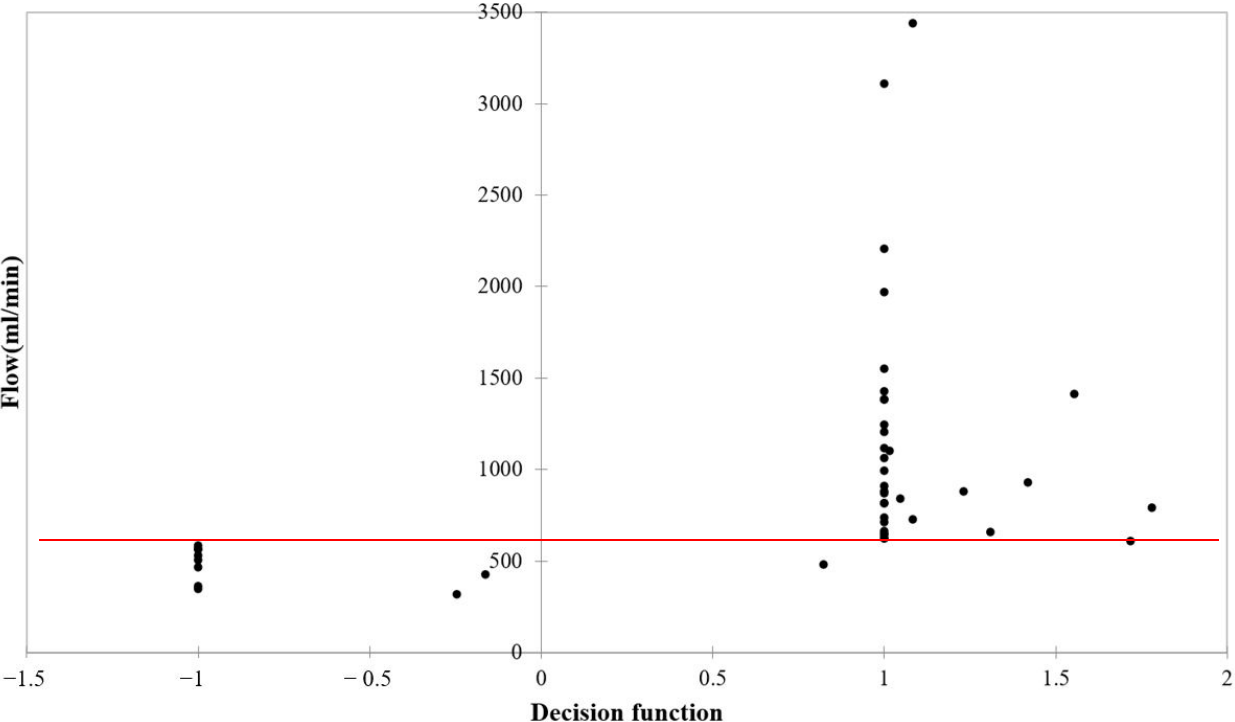
Figure 5. Results of SVM classifier training with a detection threshold of 600 mL/min. Table 2. The 10-fold cross validation results for SVM classifier at a detection threshold of 600 and 750 mL/min, respectively. Ground